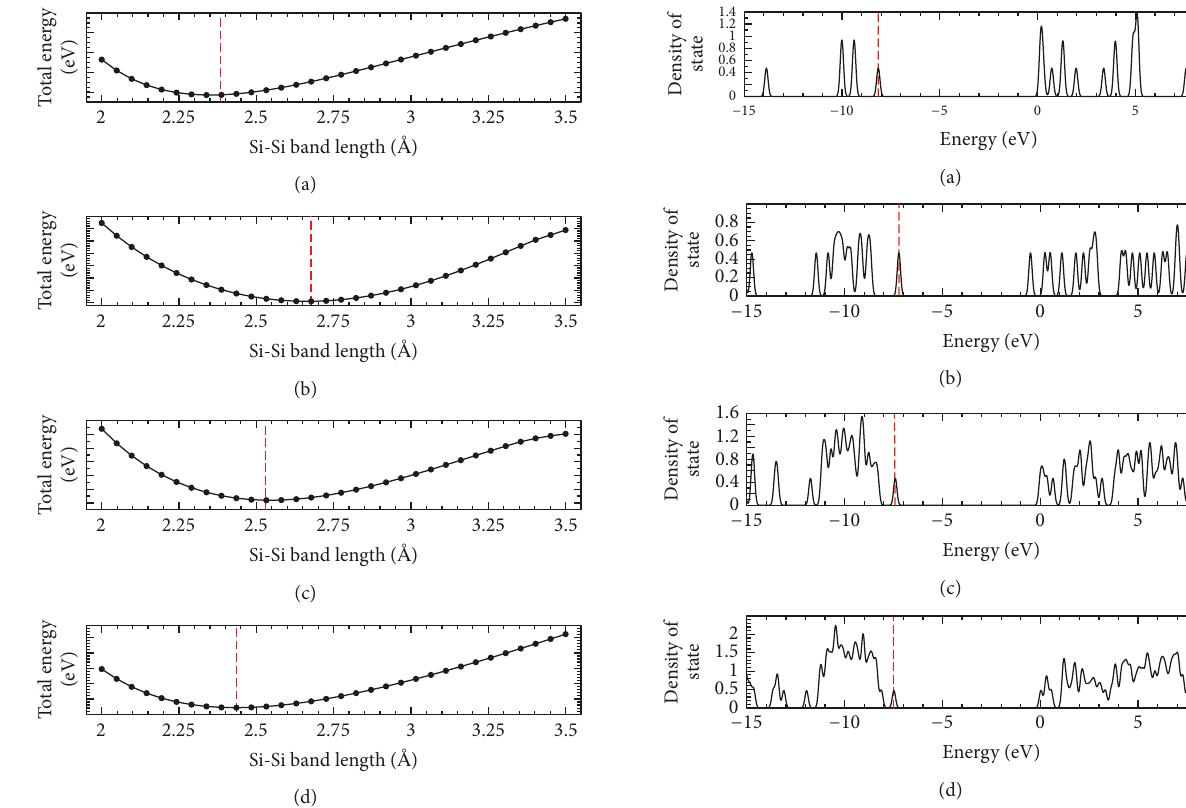
Figure 2: The relationship between total energy and Si-Si bond length in the four clusters with ODC(I) defects. (a) Si 2 H 6 , (b) Si 2 O 6 H 6 , (c) Si 5 O 15 H 12 , and (d) Si 8 O 24 H 18 .